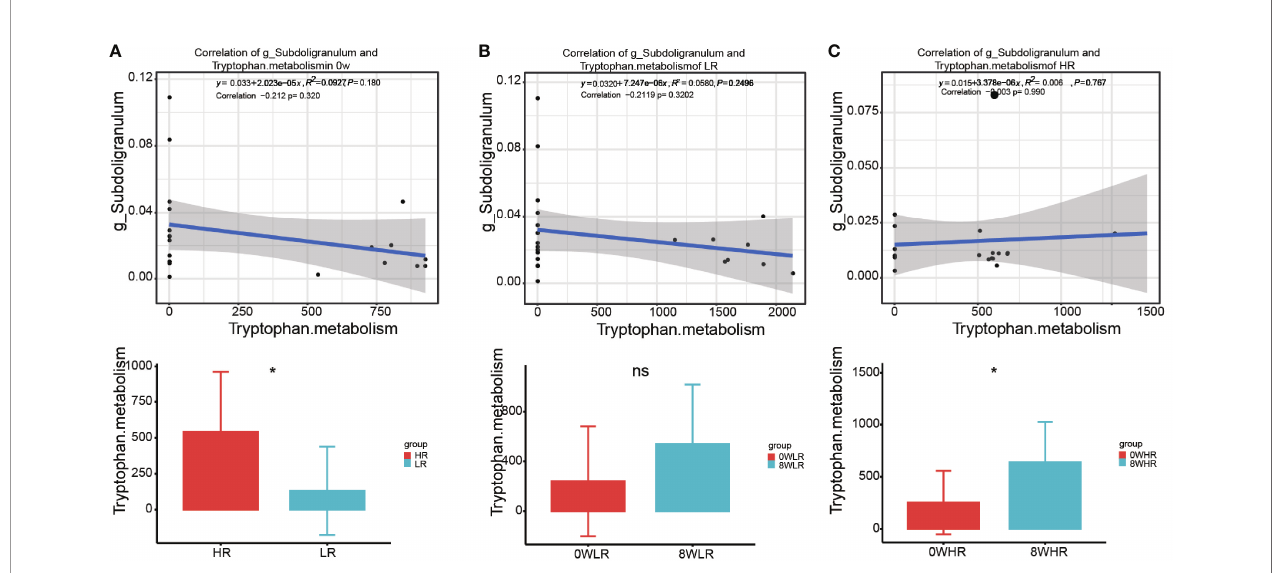
FIGURE 7 | The correlation of the taxa Subdoligranulum with Tryptophan metabolism pathway between high responders and low responders (A) , in low responders between 0 week and 8 week (B) , and in high responders between 0 week and 8 week (C) . * means p value <0.05; ns means not signi fi